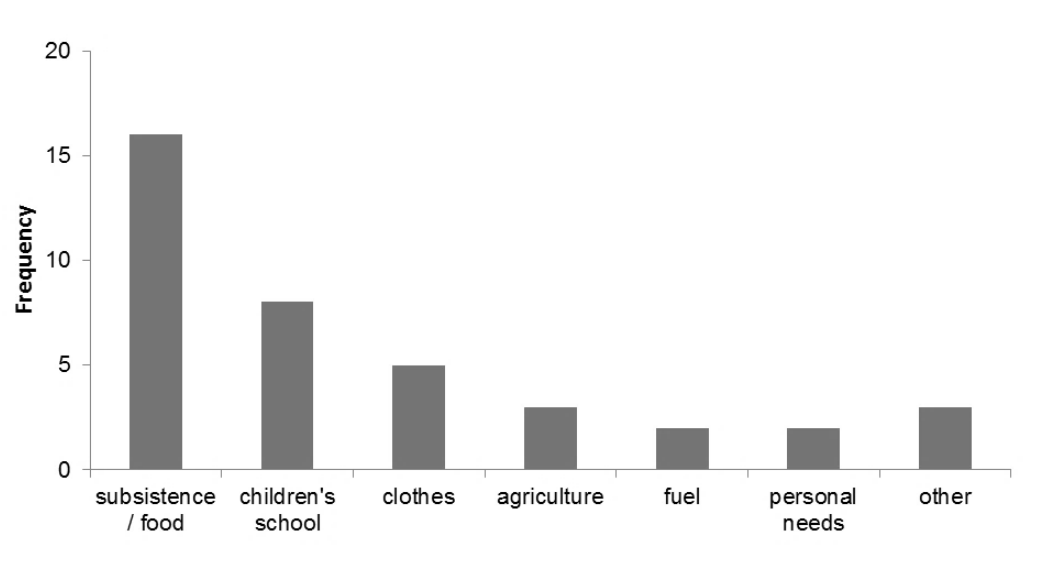
Figure A4.1. Uses of income earned from reptile and amphibian collection. Bars represent the frequencies of reported uses of wildlife collection income including subsistence (sugar, salt, coffee, rice), children’s school (fees, tools), clothes, agriculture (seeds, salary), fuel (kerosene, batteries), personal needs (pocket money, games) and other